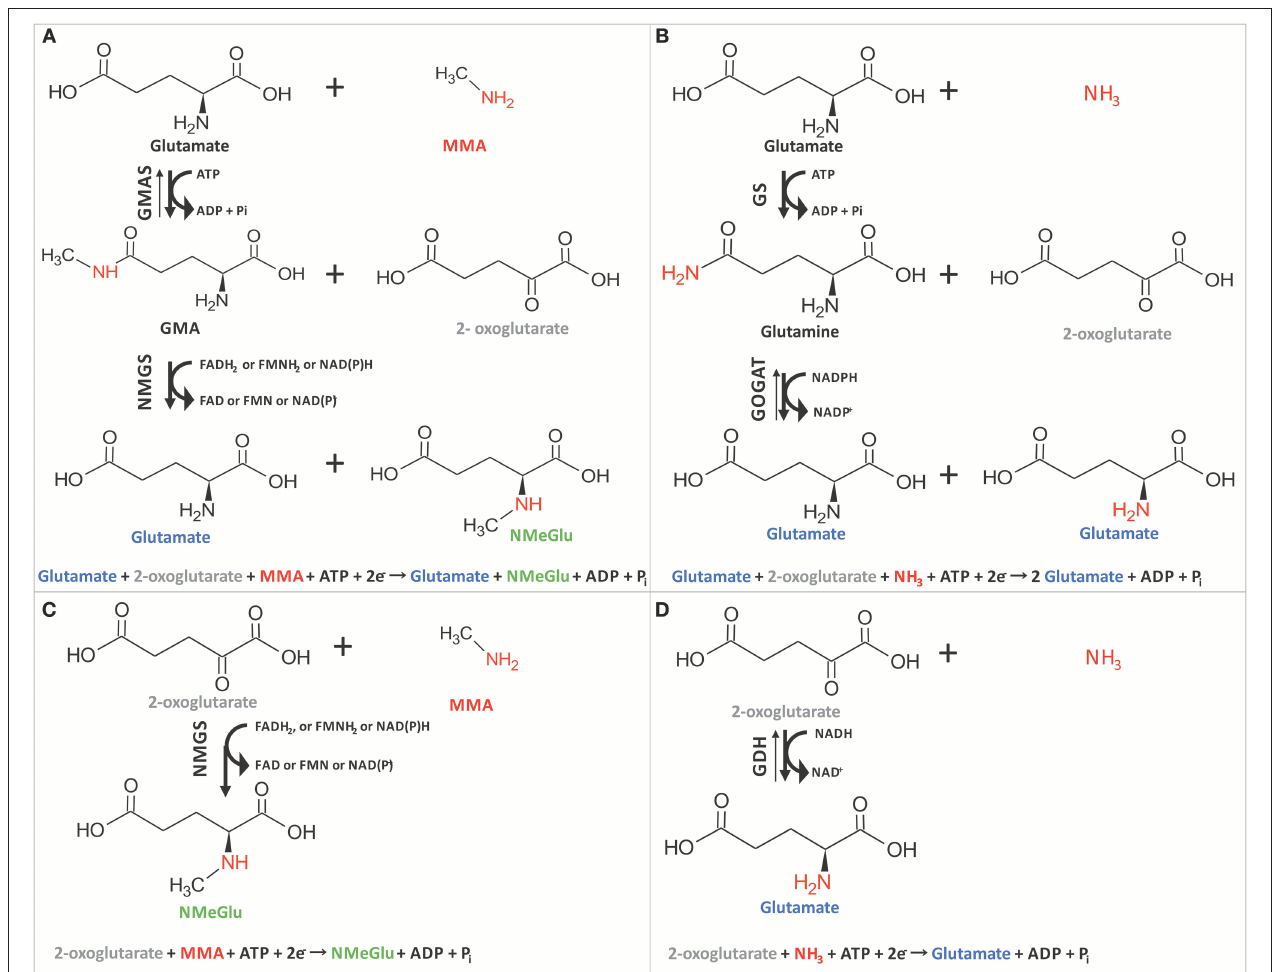
FIGURE 4 | Schematic overview of the two-step cascade of GMAS/NMGS (A) in comparison to the GS/GOGAT mechanism (B) and the proposed one-step reaction of NMGS (C) in comparison to the GDH (D) reaction. The γ -glutamylmethylamide synthetase (GMAS) amidates glutamate at C 5 position followed by a transfer of the N -methylgroup of L -glutamine to 2-oxoglutarate catalyzed by N -methylglutamate synthase (NMGS) (A) . Glutamine synthetase (GS) amidates L -glutamate to L -glutamate and the glutamate synthase catalyzes intermolecular transfer of the amino group to 2-oxoglutarate (C) . NMGS methylamidates 2-oxoglutarate at C 2 position to NMeGlu (C) . Glutamate dehydrogenase (GDH) reductively aminates 2-oxoglutarate for L -glutamate (D) .